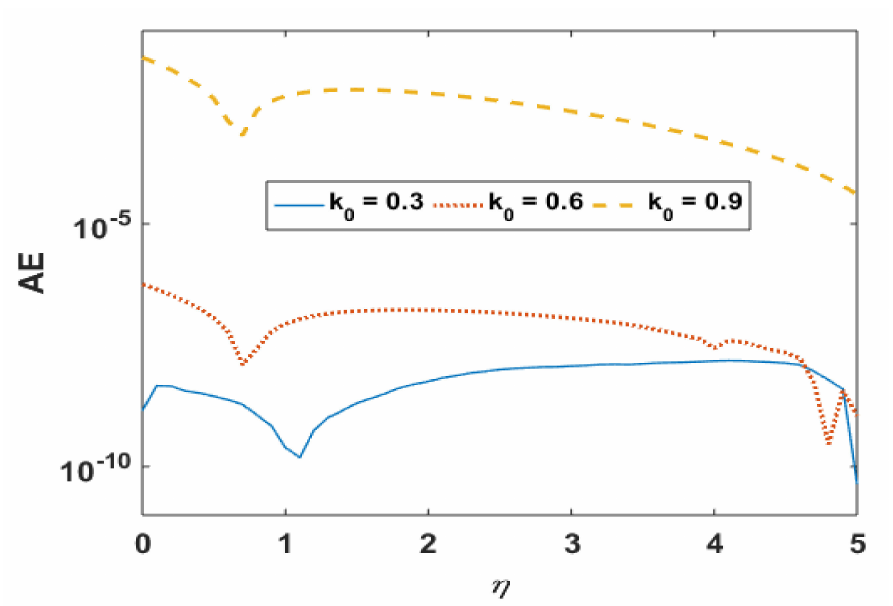
Figure 4. Absolute error in R ( η ) on different k 0